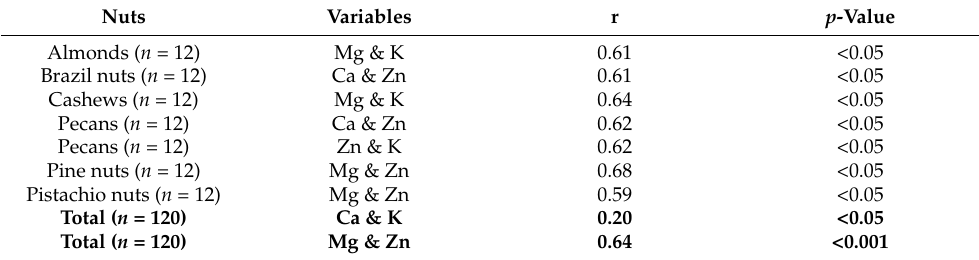
Table 4. Correlations between the contents of the examined elements.